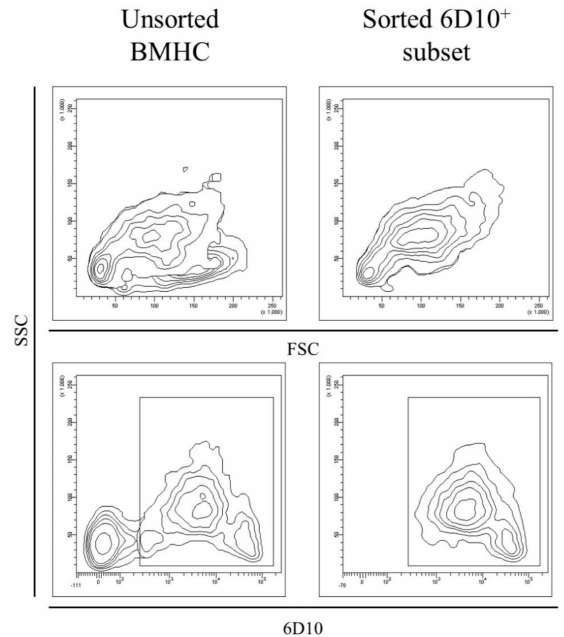
Figure 4. Evaluation of the unsorted and granulocytic (6D10 + ) cell populations in BMHC. The size and complexity (FSC versus SSC, upper part) as well as the expression of the 6D10 surface cell marker (lower part) was evaluated before and after magnetic sorting in order to detect di ff erences in the phenotypic profile of BMHC and to ensure the correct performance of the magnetic sorting, respectively. The figure is representative of CSFV persistently infected animals (pig